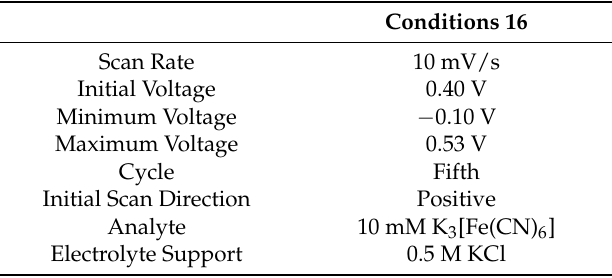
Table 8. Condition to explore the highest limit of